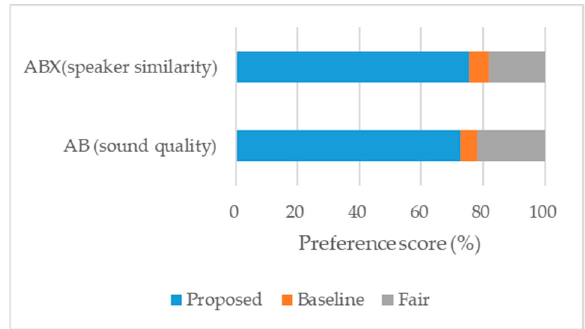
Figure 9. Results of the AB test and the ABX test.